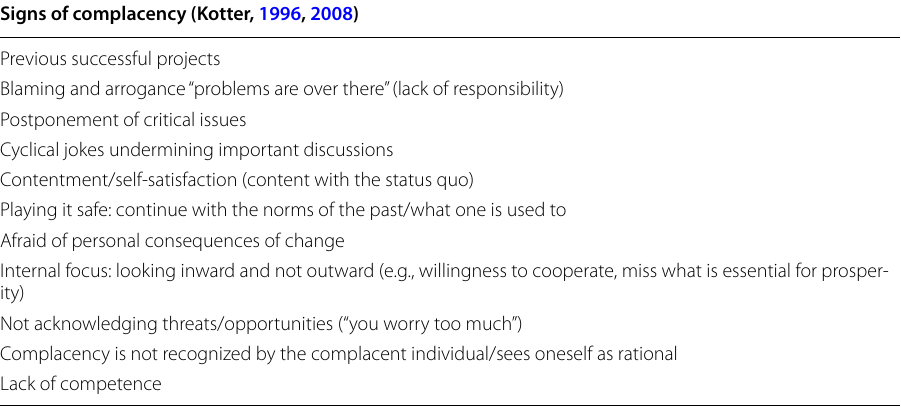
Table 1 Signs of complacency (a thought and a feeling of own behavior) (Kotter, 1996, 2008) Signs of complacency (Kotter, 1996, 2008) Previous successful projects Blaming and arrogance “problems are over there” (lack of responsibility) Postponement of critical